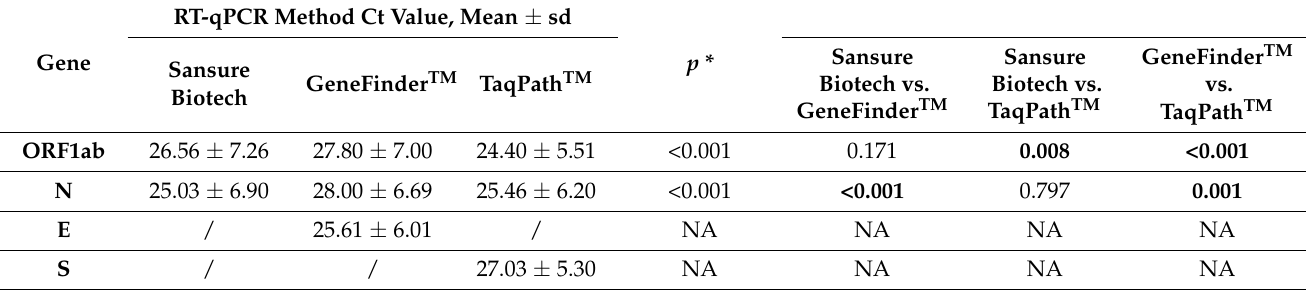
Table 3. Ct values and comparison of three different RT-qPCR methods.